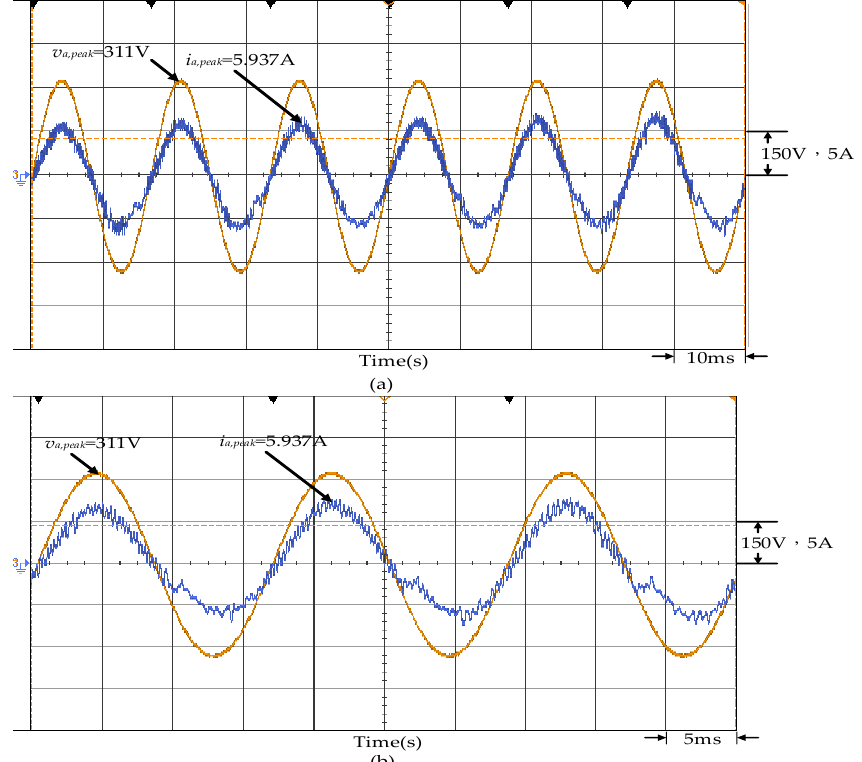
Figure 18. When the per-unit value of mains voltage in smart inverter under Phase a was between 1p.u. and 1.03p.u.: ( a ) output voltage and current waveforms under the actual test; ( b ) partial waveform enlargement of Figure ( a ).